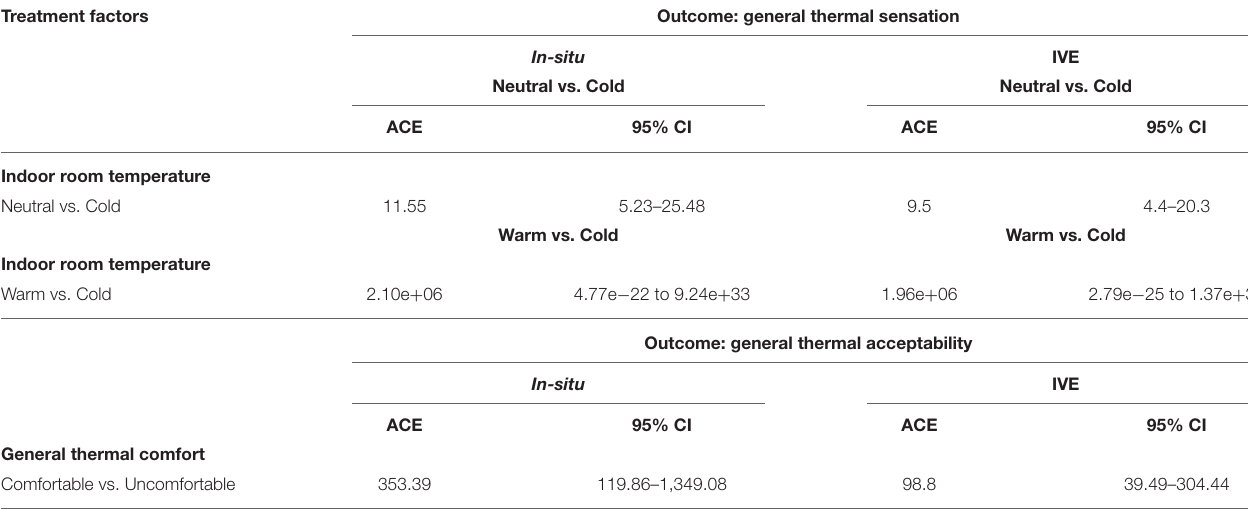
TABLE 4 | Average causal effect estimates of treatment factors influencing GTS and GTA.